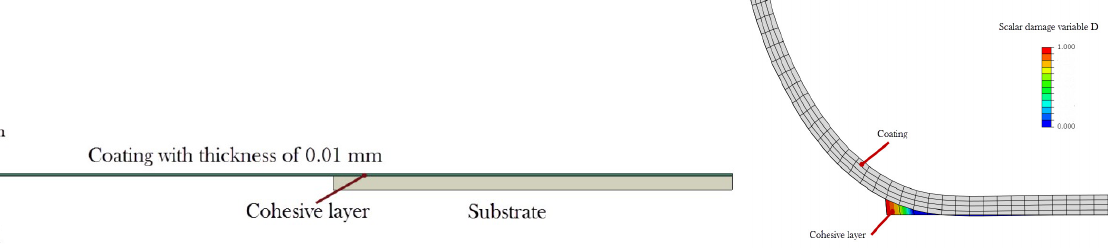
Figure 9: Finite element model of the peeling test (left); detail of the FE analysis mesh and